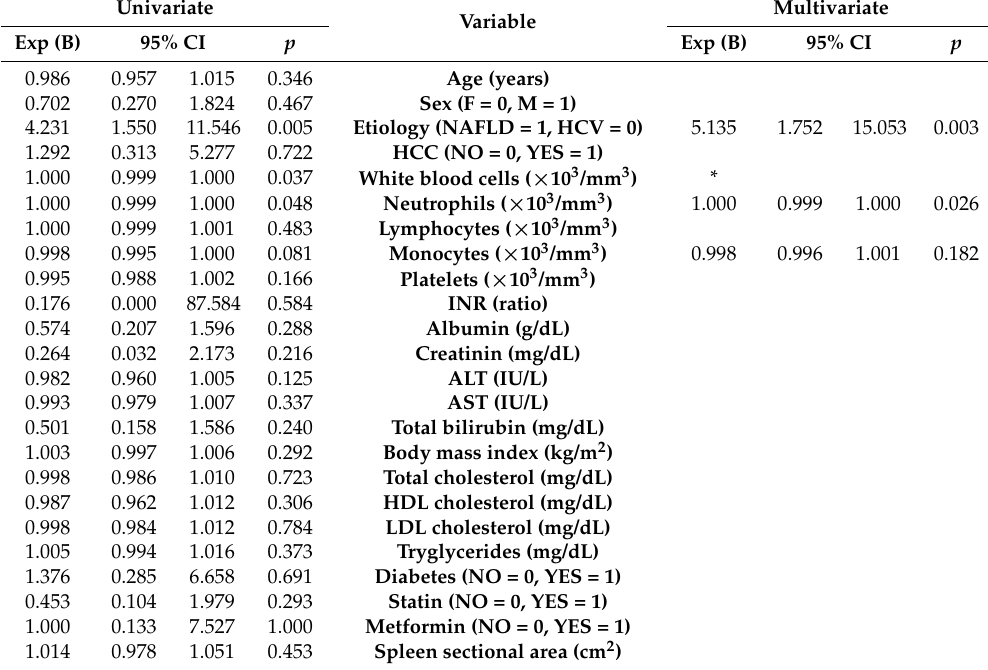
* Excluded for multivariate analyses due to co-linearity. INR: international normalized ratio; AST: aspartate aminotranferase; ALT: alanine aminotranferase; HDL: high-density lipoprotein; LDL: low-density